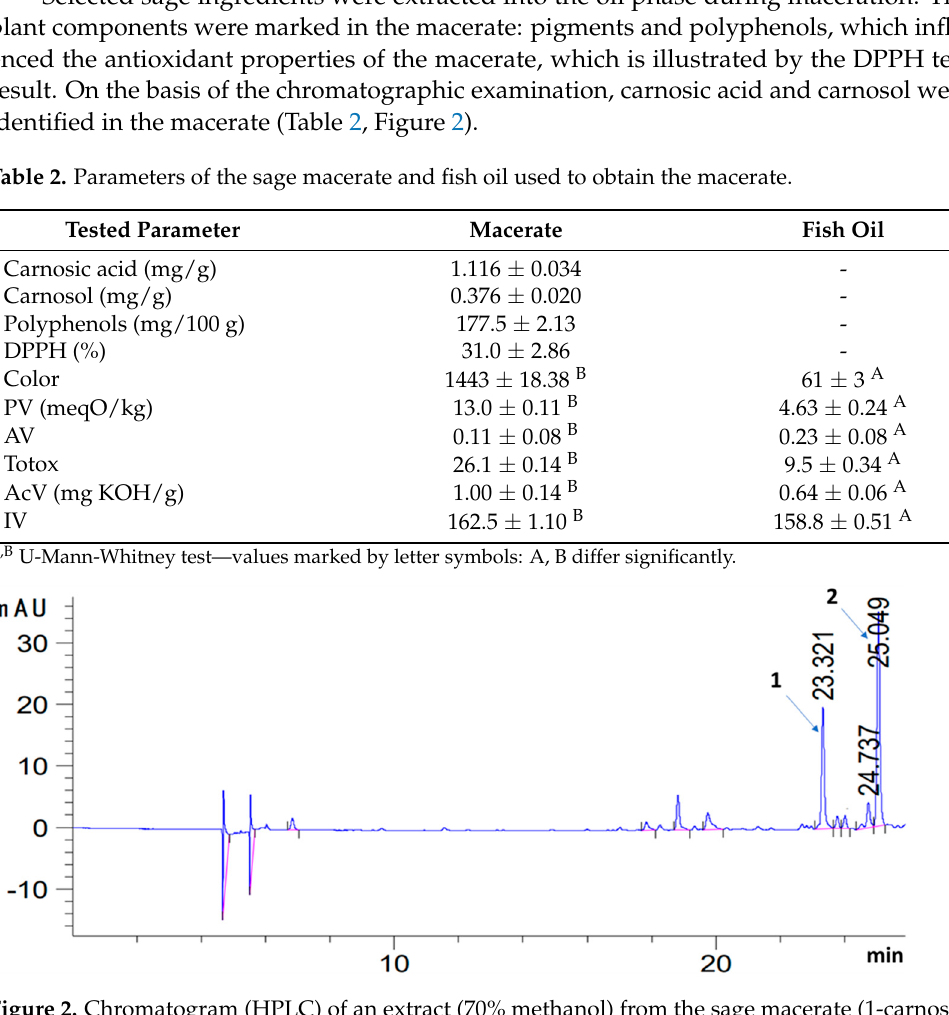
Figure 3. Taste (t) and odor (s) profile macerate (M, green) compared to pure cod liver oil (FO, or- ange). 3.3. Storage of Sage Macerate at Refrigeration Temperature j (4–5 °C) and Room (20–25 °C) Along with the storage time of the macerate, both at room temperature and refriger- ated temperature, PV, AV, AcV, Totox index increased, but at 4 °C the changes of these parameters were much slower (Tables 3 and 4). However, a significant increase of PV,